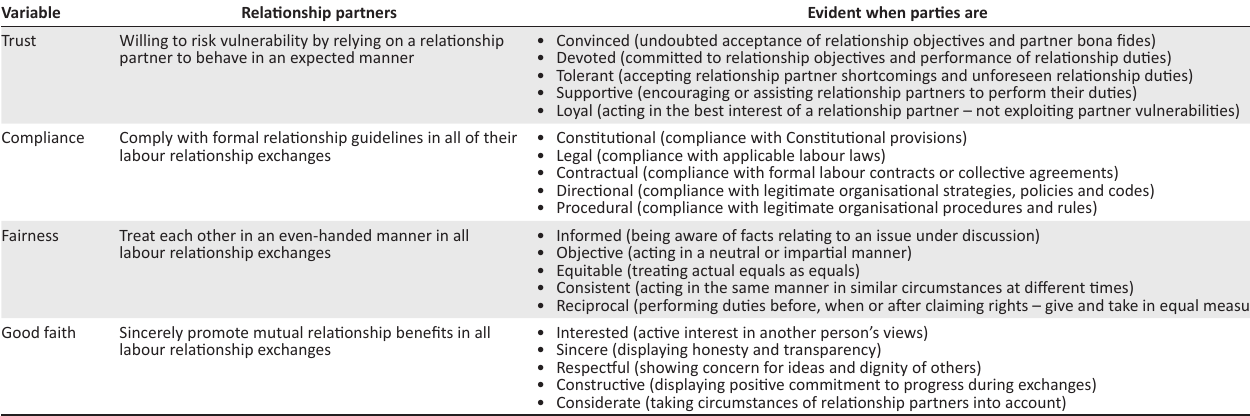
TABLE 1: Facilitators of good-quality labour relationships. Variable Relationship